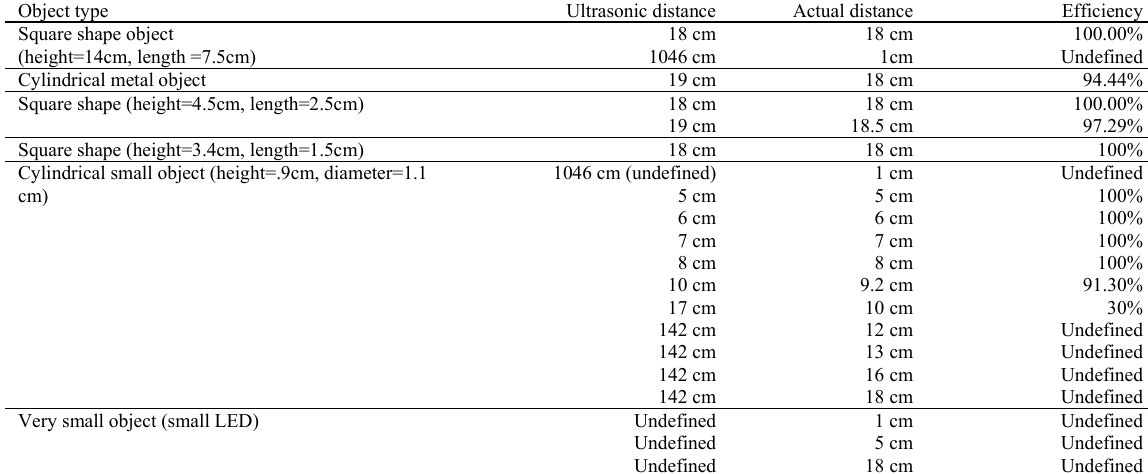
TABLE 5 R ADAR S YSTEM P ERFORMANCE E VALUATION A GAINST D IFFERENT S HAPE OF O